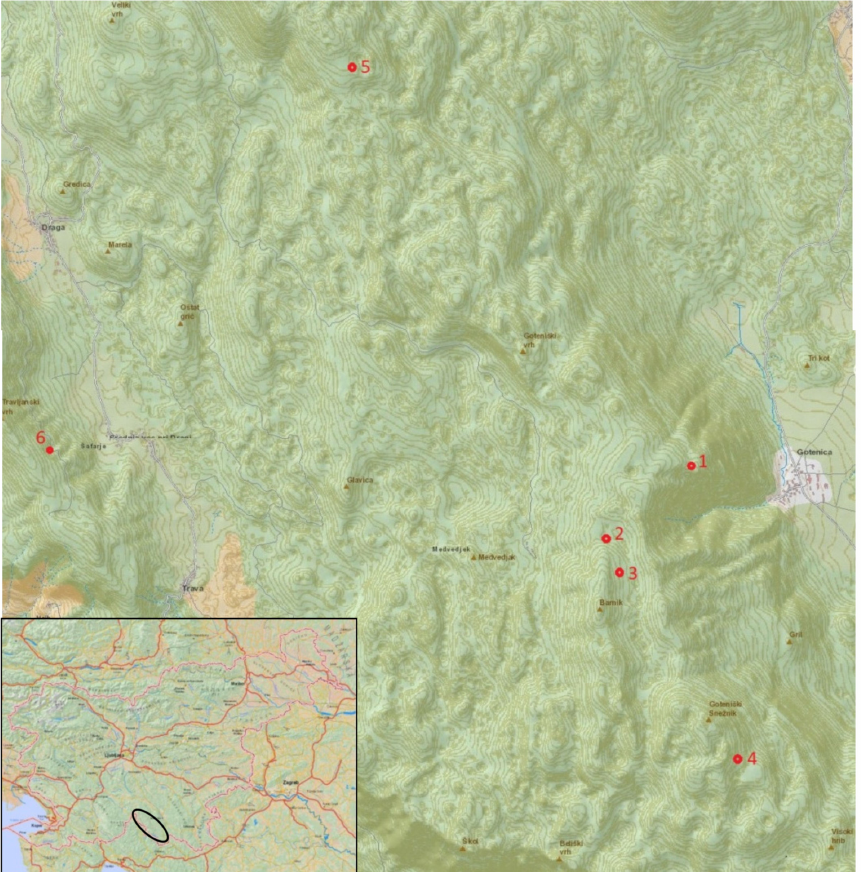
Figure 1. Locations of 6 sampling sites on map (1: Stone Wall, 2: Below Barnik, 3: Above Barnik, 4: Goteniški Snežnik, 5: Goteniška gora, 6: Above Draga). (Source: http://gis.arso.gov.si/atlasokolja/